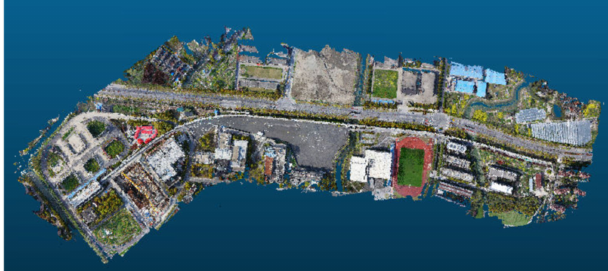
Figure 11. Overall effect of dense point clouds of magnetic levitation track.